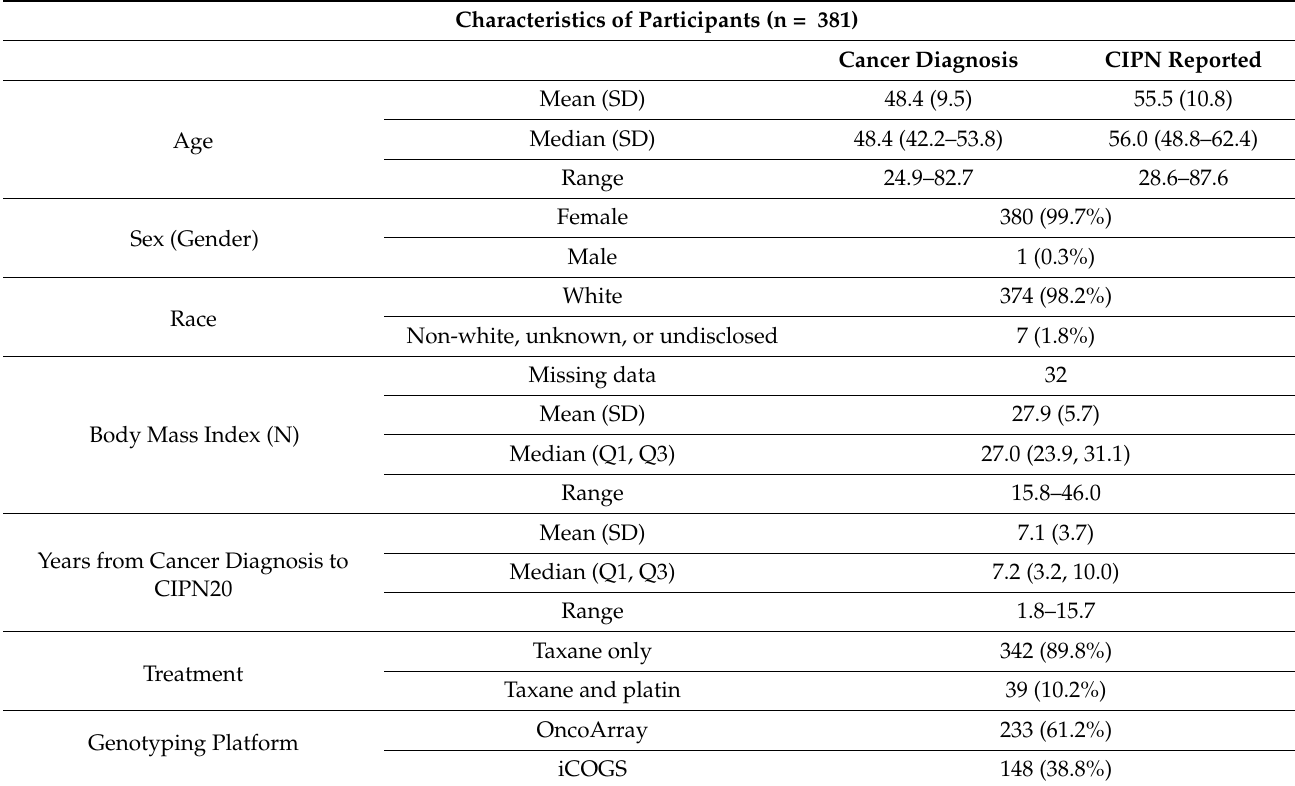
Table 3. Baseline characteristics of the Mayo Clinic Breast Disease Registry (MCBDR) GWAS cohort.